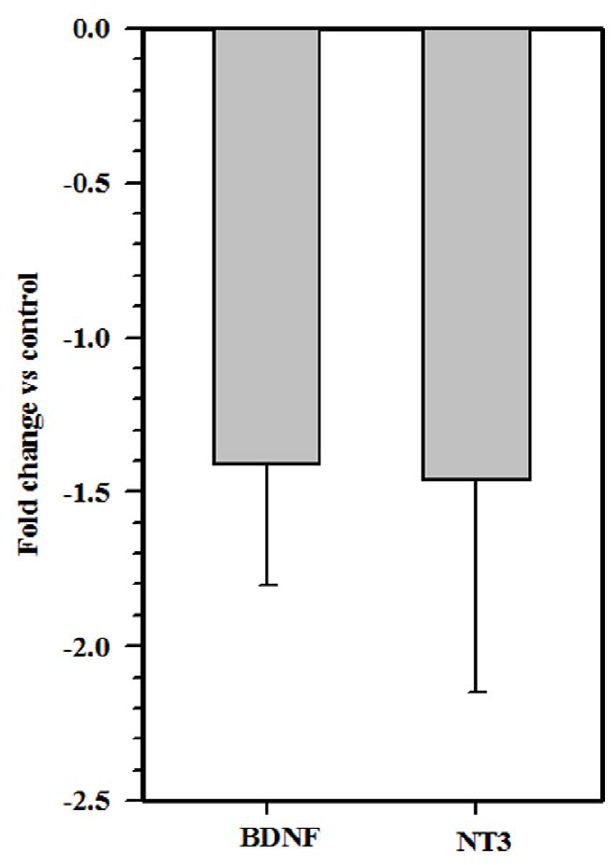
Figure 8. MCMV brain infection of the neonates down- regulates neurotrphin expression levels. BDNF and NT3 mRNA expression was assessed using quantitative real-time RT-PCR on total RNA extracted from whole brain homogenates of control and virus- infected neonates at 7 d p.i. mRNA levels were normalized to HPRT and are presented as mean 6 SD normalized expression from pooled data obtained using 3–5 animals per group from 2 independent exper-